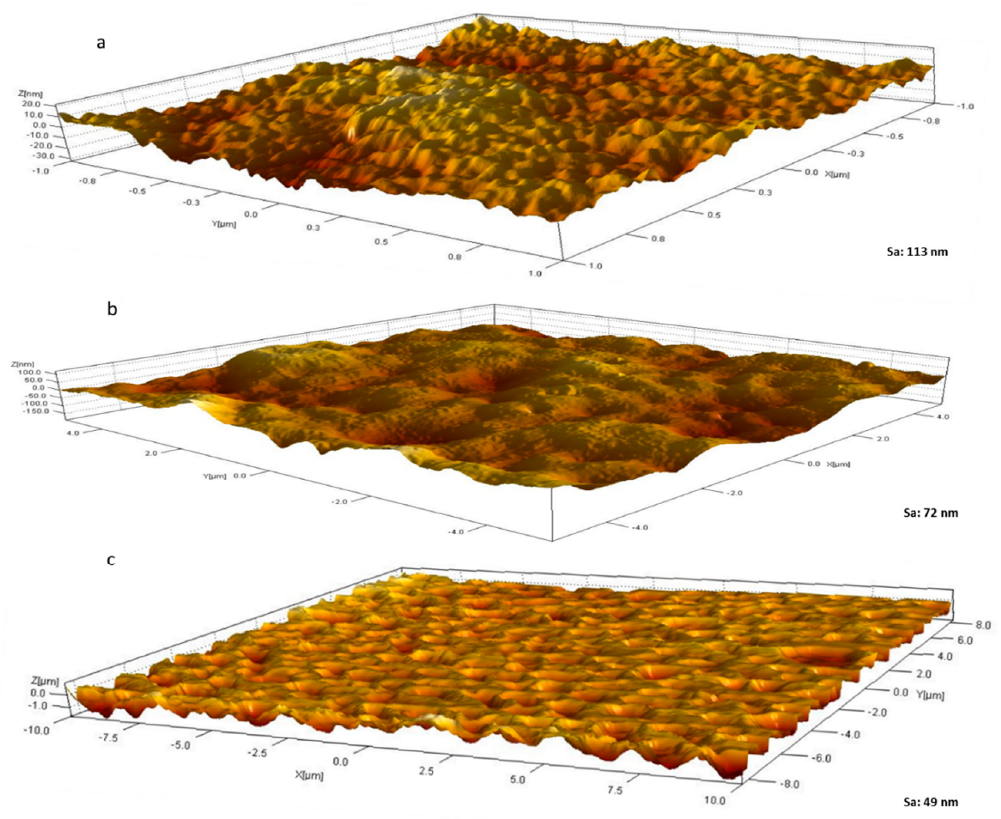
Figure 8. 3D AFM surface images for M1 ( a ); M7 ( b ); and M8 ( c ) samples. Mean surface roughness (Sa) values are indicated.